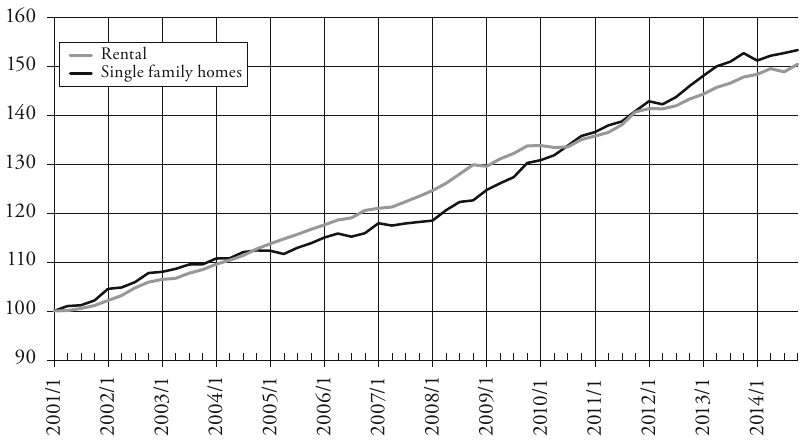
Figure 2: Rental versus Single-Family Home